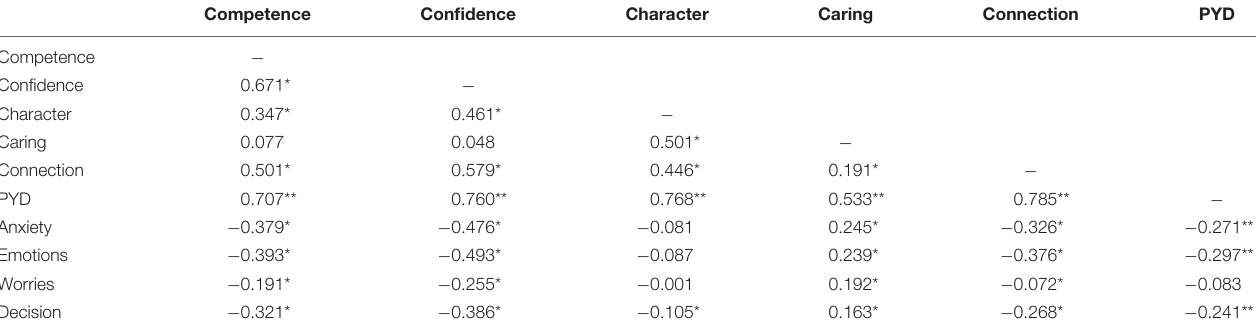
TABLE 3 | Correlations between the global PYD factor, the 5Cs, and anxiety, and its components in the Slovenian sample. Competence Confidence Character